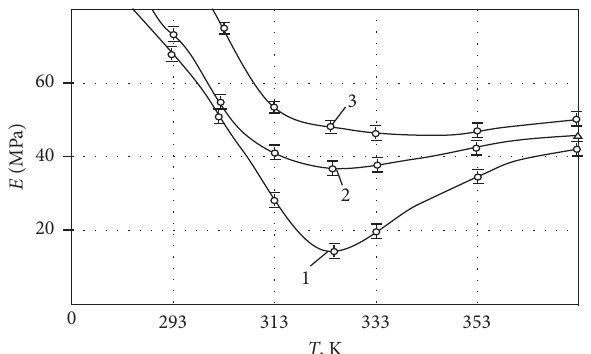
Figure 4: The dependence of elasticity modulus change under bending on temperature for compositions based on epoxy resin, hardened according to the modes given in Table 1 (curve numbers correspond to composition numbers given in Table 2).